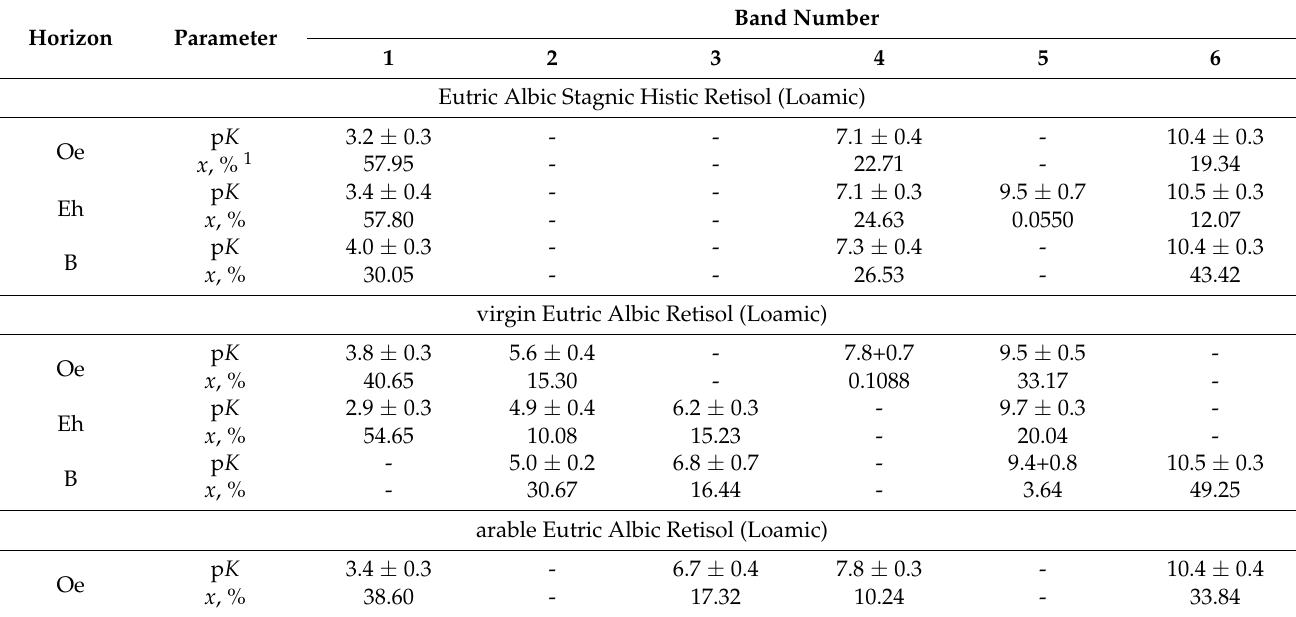
Table 3. Characteristics of p K spectra of fulvic